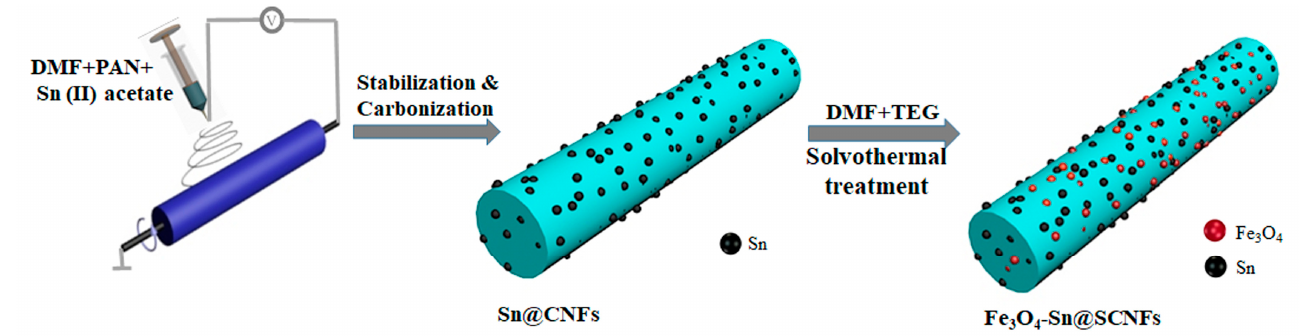
Figure 1. Schematic illustration of the preparation process for Fe 3 O 4 @Sn-CNFs. As shown in Figure 2a, the crystalline textures of CNFs, Sn@CNFs, Fe 3 O 4 , Fe 3 O 4 @CNFs, and Fe 3 O 4 -Sn@CNFs were analyzed by X-ray diffraction (XRD). The XRD pattern of the CNFs reveals two broad and smooth peaks approximately at 2 θ = 25 ◦ and 44 ◦ ; the former peak proved the formation of typical amorphous carbon [60,61], and the latter weaker peak indicated the presence of a little ordered carbon in the CNFs [62]. The XRD pattern of the Fe 3 O 4 powder exhibited diffraction peaks at 2 θ = 18.2 ◦ , 30.0 ◦ , 35.4 ◦ , 37.0 ◦ , 43.0 ◦ , 53.4 ◦ , 56.9 ◦ , and 62.5 ◦ , corresponding to the (111), (220), (311), (222), (400), (422), (511), and (440) planes, respectively, indicating a cubic Fe 3 O 4 structure with a space group of F d -3 m (JCPDS No. 89-0688). In addition, compared to Fe 3 O 4 powder, the Fe 3 O 4 peaks of Fe 3 O 4 @CNFs and Fe 3 O 4 -Sn@CNFs were weaker in intensity, indicating that Fe 3 O 4 did not accumulate on the surface of the fibers, but formed a small nanoscale structure. The corresponding peaks at 2 θ = 30.6 ◦ , 32.0 ◦ , 43.9 ◦ , 44.9 ◦ , 55.3 ◦ , 62.5 ◦ , 63.8 ◦ , 64.6 ◦ , 72.4 ◦ , 73.1 ◦ , and 79.5 ◦ could be indexed to the (200), (101), (220), (211), (301), (112), (400), (321), (420), (411), and (312) planes of Sn metal, respectively, and were accordant with a tetragonal structure, expressing a space group of I4 1 /amd (JCPDS No. 65-0296). Fe 3 O 4 -Sn@CNFs have a similar peak of Sn as Sn@CNFs, implying the microstructure of Sn has not been influenced by the solvothermal reaction and subsequent treatment process. The decrease in peak intensity and SEM results proved that many Fe 3 O 4 particles were coated on the Sn@CNFs and constituted a Fe 3 O 4 shell. peaks, located at 288.7 eV, 286.1 eV, and 284.8 eV, which correspond to the chemical bonds (O=C–O and O=C) formed by O elements remaining in the preparation and calcination process and the C–C chemical bond in CNFs themselves [63,64]. The peaks at 495 eV and 486.5 eV in Figure 2d correspond to Sn 3d3/2 and Sn 3d5/2 respectively, which proved the presence of Sn in the Fe 3 O 4 -Sn@CNFs samples [65]. Figure 2e shows the oxygen element in the XPS pattern of the O 1s spectrum diagram, and two peaks can be deconvoluted into four peaks. The peak at 530.2 eV corresponds to the Fe-O bond in the crystalline phase of Fe 3 O 4, and the different combinations of O and C states (O=C and O–C chemical bonds) correspond to two neighboring peaks at 531 eV and 532.2 eV respectively. The higher peak at 533.5 eV may be attributed to the O–H bond of the adsorbed water molecules [66]. Figure 2f shows the Fe 2p spectrum of two peaks located at 725 eV and 710.3 eV, corresponding to Fe 2p1/2 and Fe 2p3/2 respectively, with a satellite peak at 717.5 eV, confirming the presence of Fe